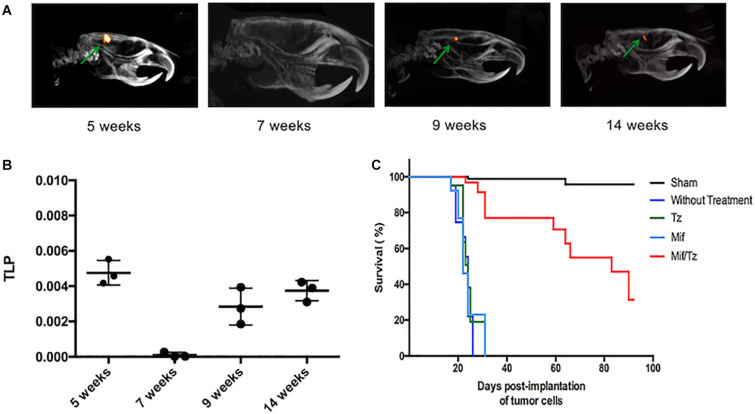
Proliferative activity in the orthotopic model of glioma evaluated by PET/CT images showing tumor uptake of 18F-FLT. (A) The images reveal the relative tumor size at 5, 7, 9, and 14 weeks post-surgery. Drug treatments were given from weeks 2–5. (B) The activity proliferative of tumors measured as total proliferation (TLP). (C) Survival analysis for 100 days after tumor cells implantation.